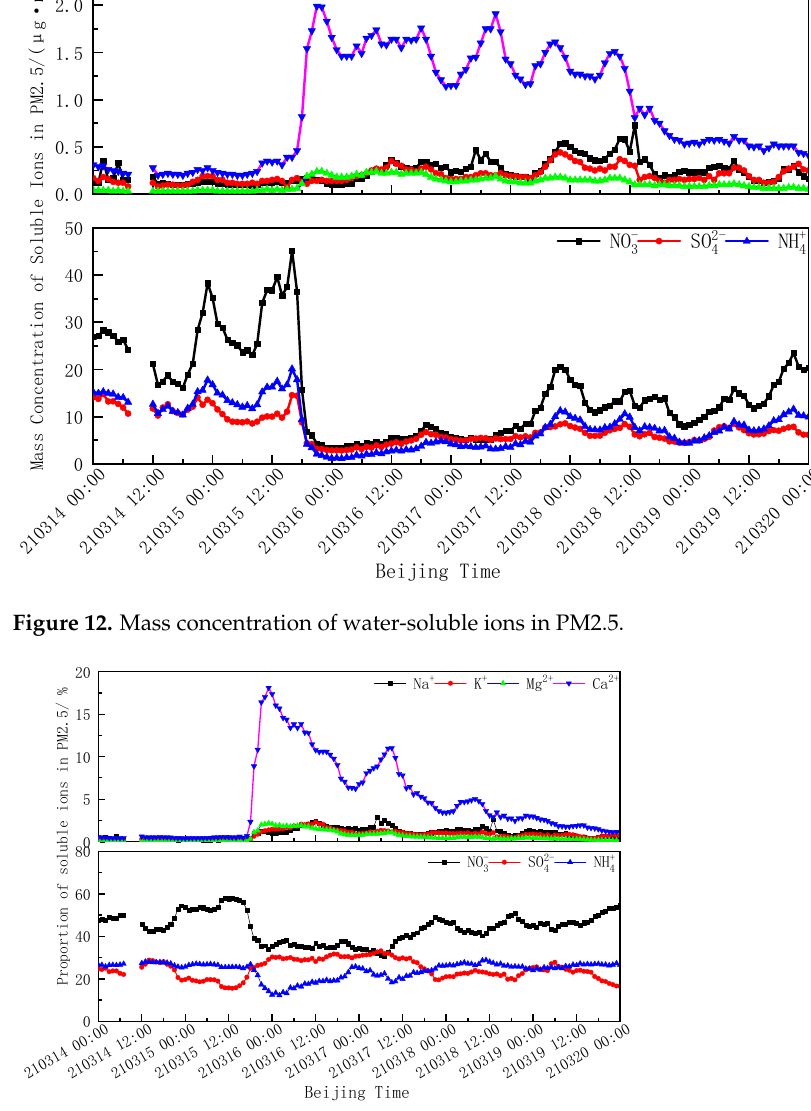
Figure 13. Proportion of water-soluble ions in PM2.5.